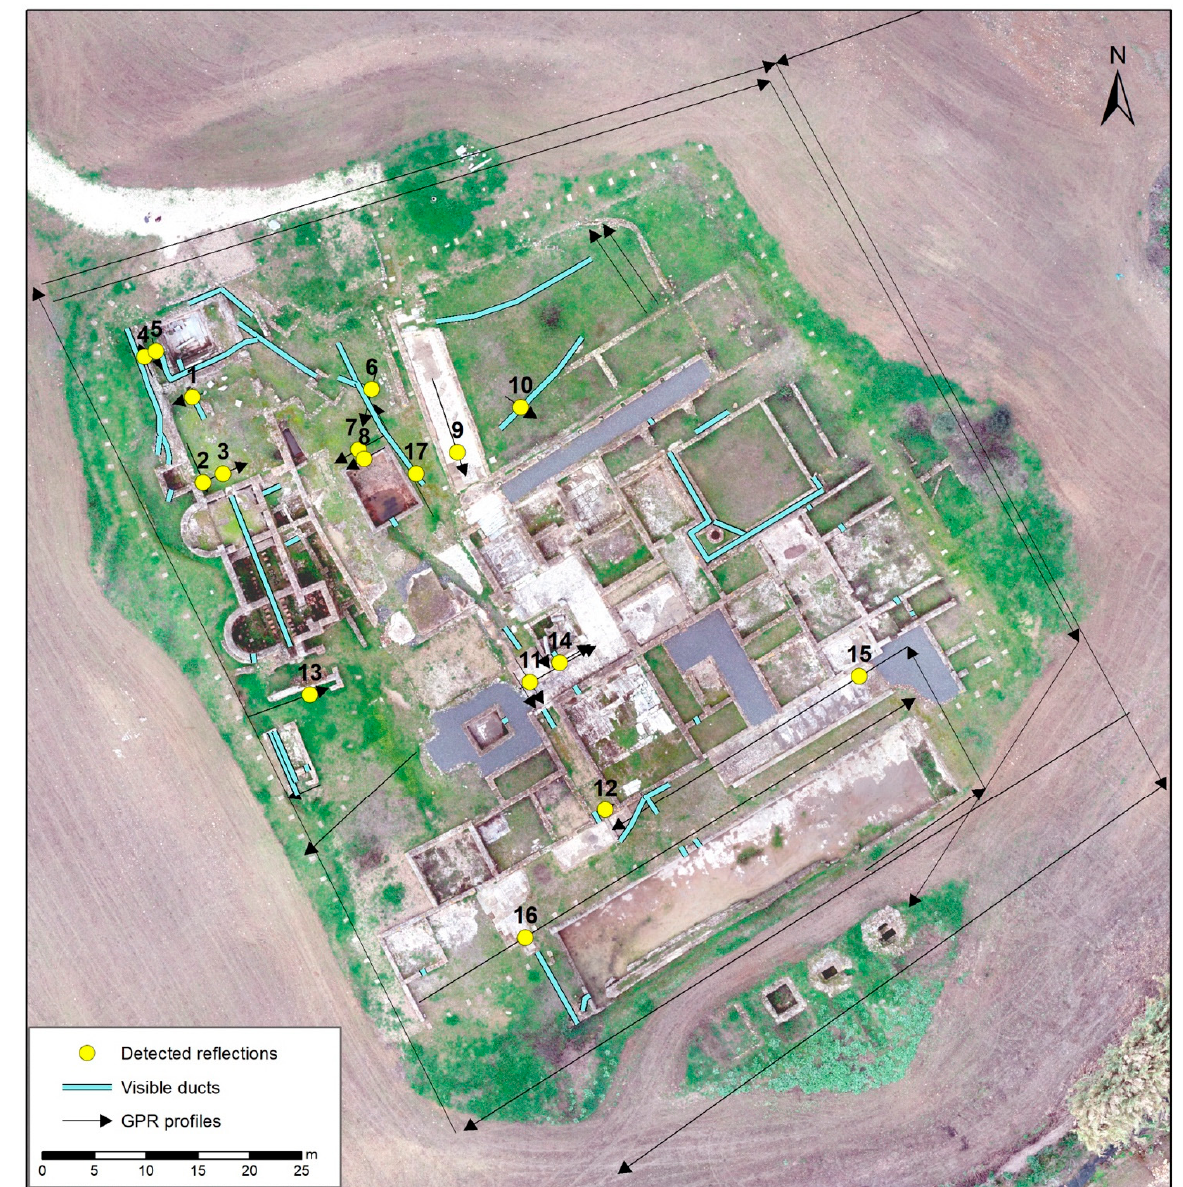
Figure 6. Location of the GPR reflection patterns compatible with water conduits.